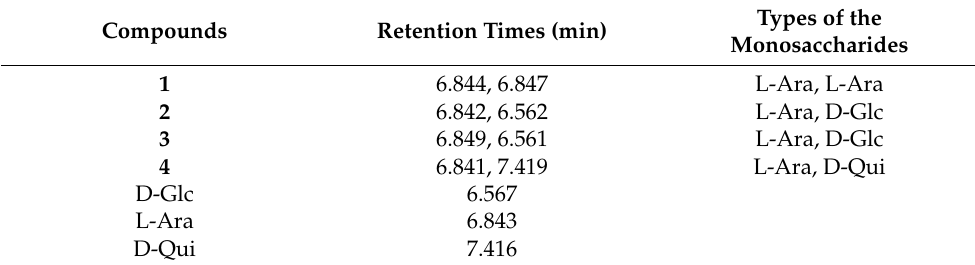
7.416 Cypaliuruside Z 2 ( 2 ) was deduced to have the molecular formula C 38 H 62 O 13 by HRESIMS m / z 749.4075 [M + Na] + (calculated for C 38 H 62 O 13 Na, 749.4088) (Figure S9),